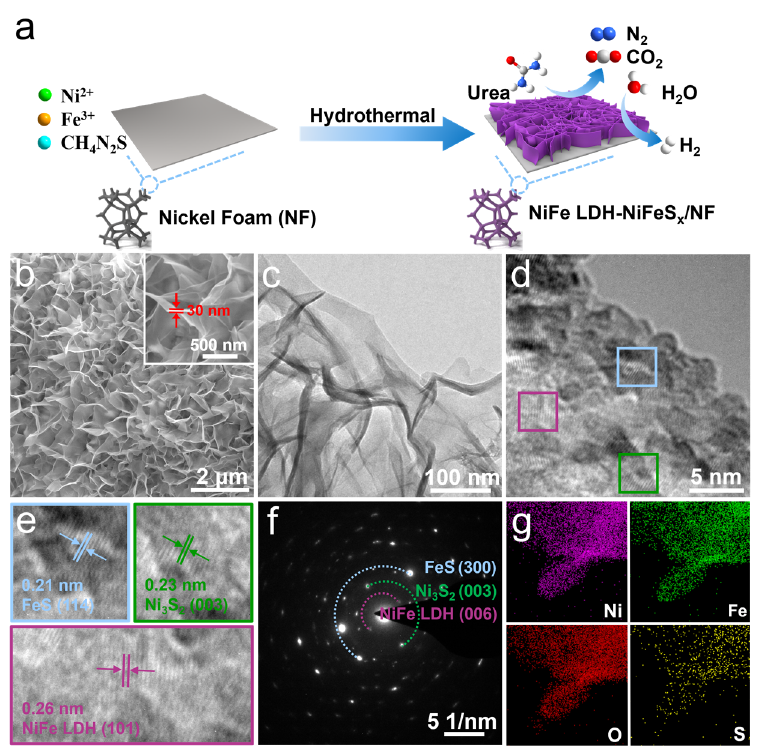
Figure 1. ( a ) Schematic illustration for the fabrication process of NiFe LDH-NiFeS x /NF. ( b ) SEM, ( c ) TEM, ( d , e ) HRTEM, ( f ) SAED pattern, and ( g ) EDS elemental mapping images of NiFe LDH- NiFeS x /NF.